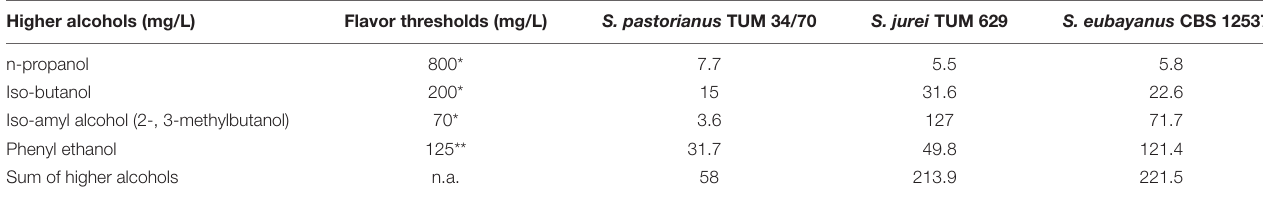
TABLE 5 | Higher alcohols detected in the three different beer samples fermented by S. pastorianus (TUM 34/70), S. jurei (TUM 629) and S. eubayanus (CBS 12537) at a fermentation temperature of 15 ◦ C and an original gravity 12 ◦ P. Higher alcohols